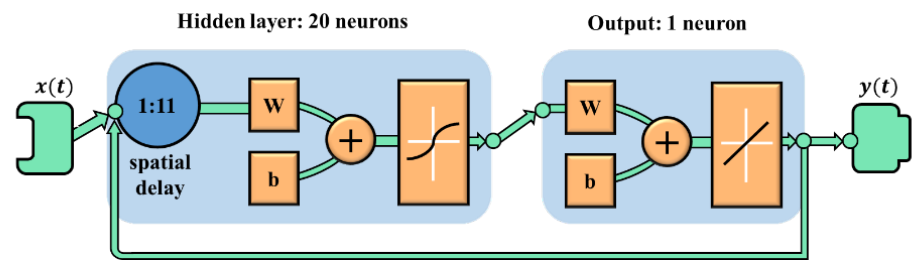
Figure 18. The prediction process of the NARNN. Table 4. Parameter setting of the NARNN.